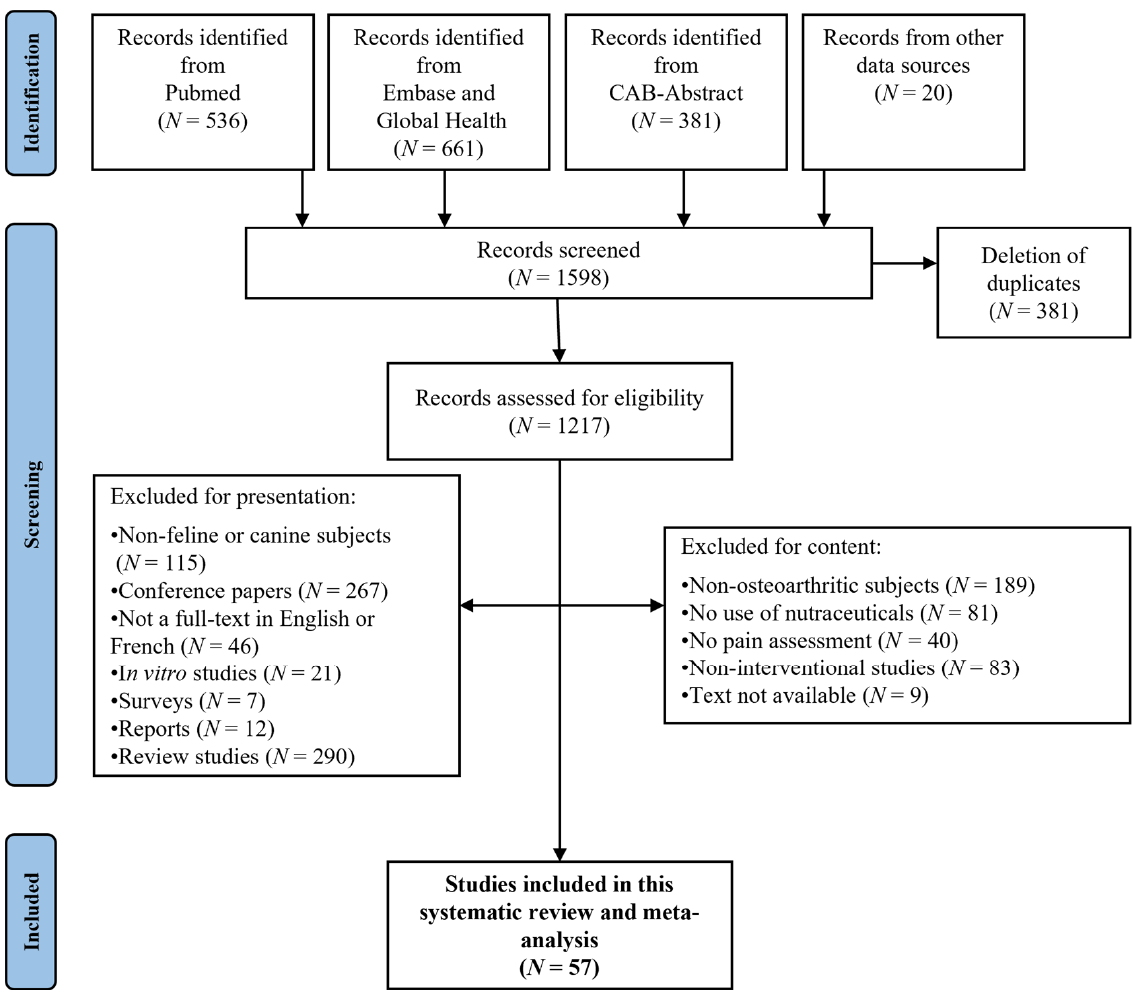
Figure 1. PRISMA flowchart of publications on use of nutraceuticals and therapeutic diets in canine and feline OA .